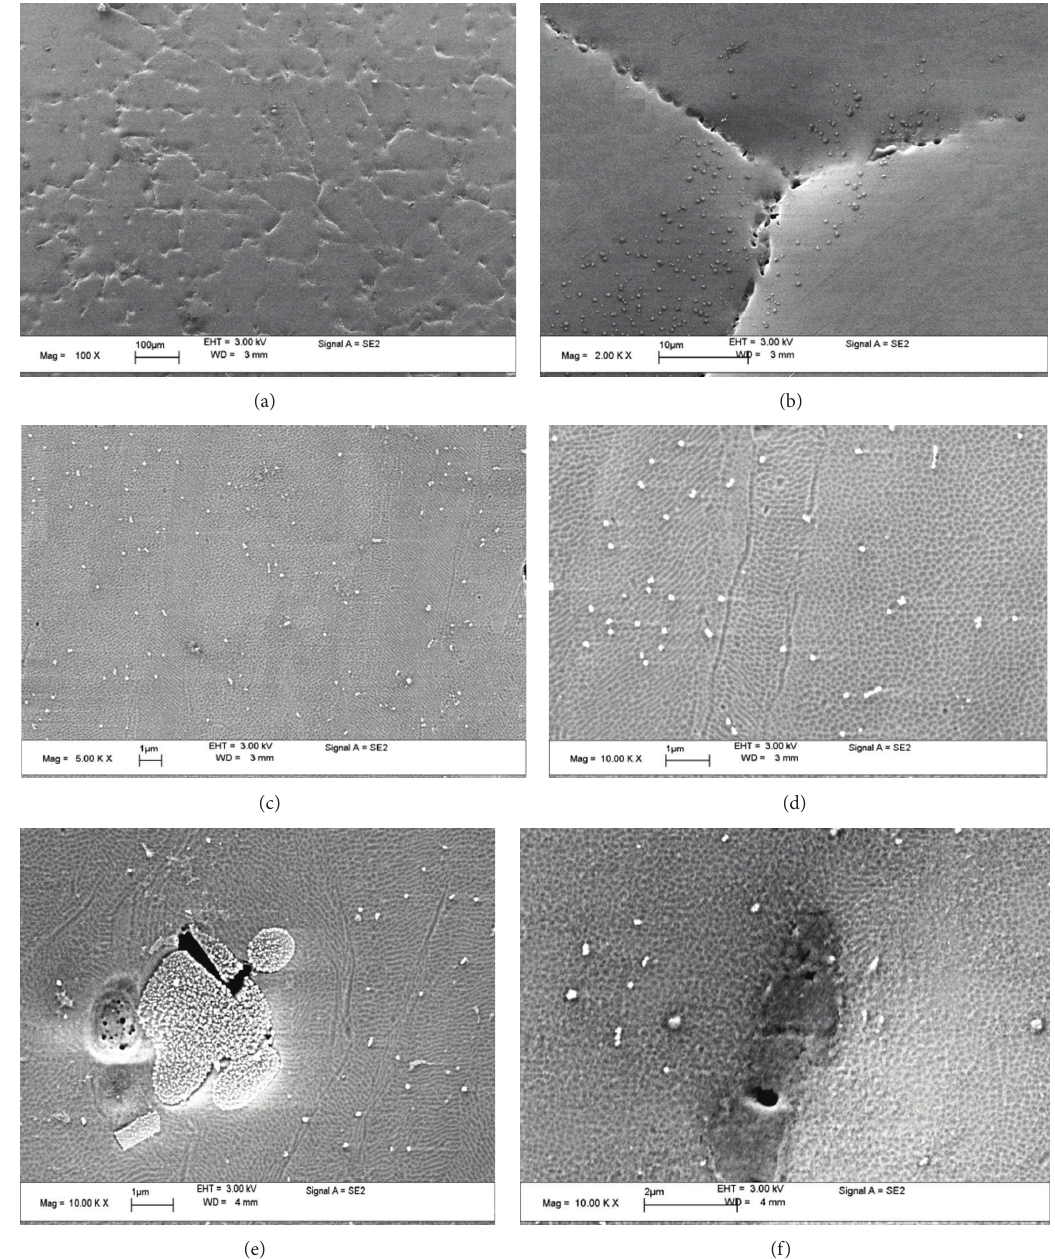
Figure 4: SEM micrographs with two magnifications showing the microstructure of (a, b) the nondeformed ( 𝑁 = 0 ) aluminium matrix containing 𝛼 -phase particles, (c, d) after ECAP ( 𝑁 = 4 ), and the effect of ECAP on the 𝛼 -phase particles, that is, (e) breakdown and (f) partial